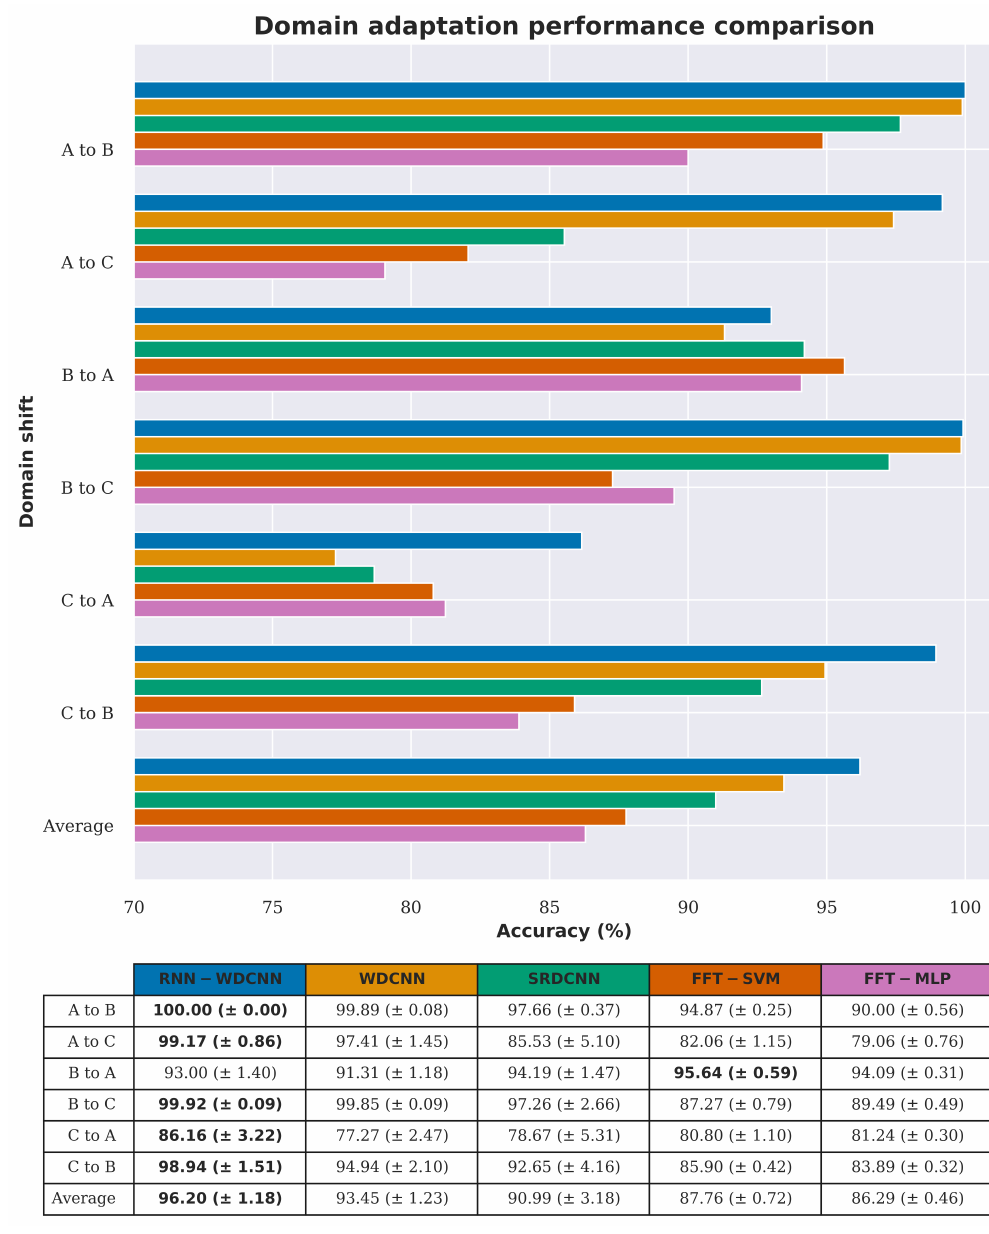
Figure 8. Domain adaptation accuracy comparison between RNN-WDCNN and WDCNN, state-of-the-art deep learning-based models (SRDCNN), and FFT-based methods for scenario 1 (best values are highlighted in